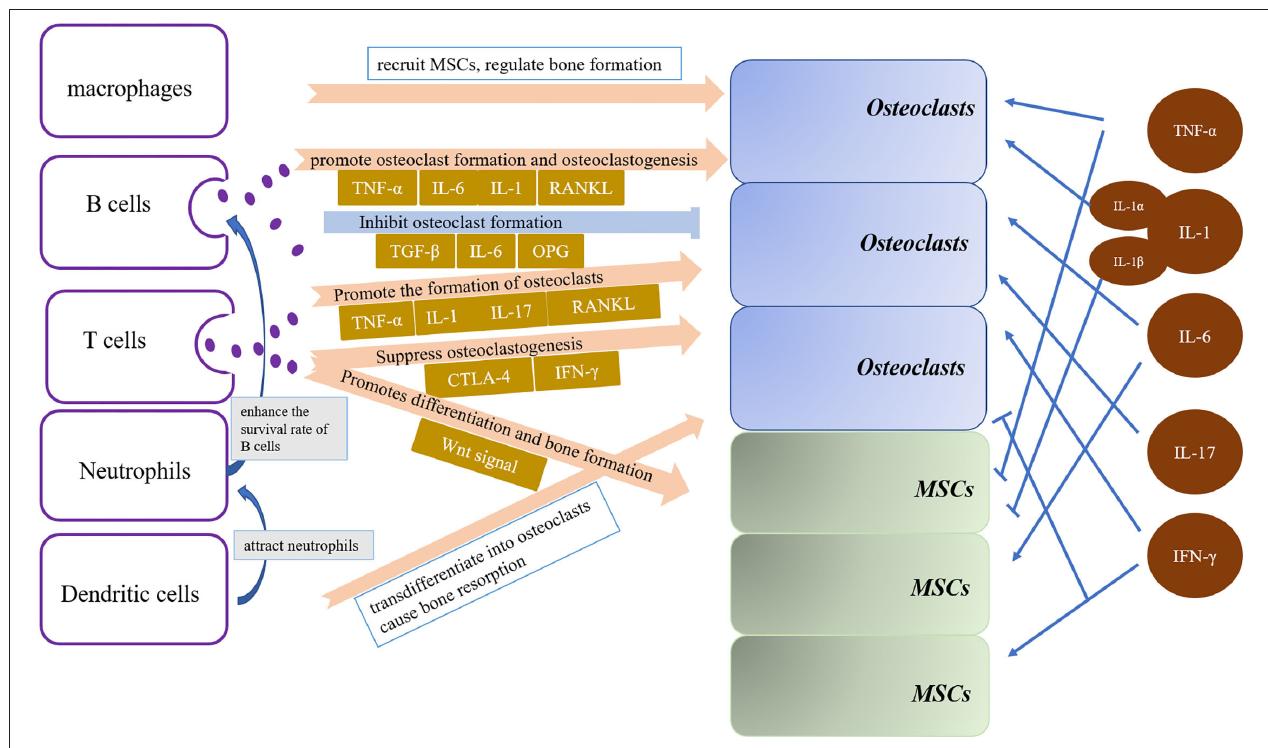
FIGURE 1 | Cytokines and immune cells are important factors in regulating bone resorption in bone homeostasis. Osteoclasts and osteoblasts differentiation and activation are driven by immune cells, including B cells, T cells, dendritic cells, macrophages and neutrophils, and cytokines, containing TNF-a, IL-1, IL-6, IL-17 and IFN- γ